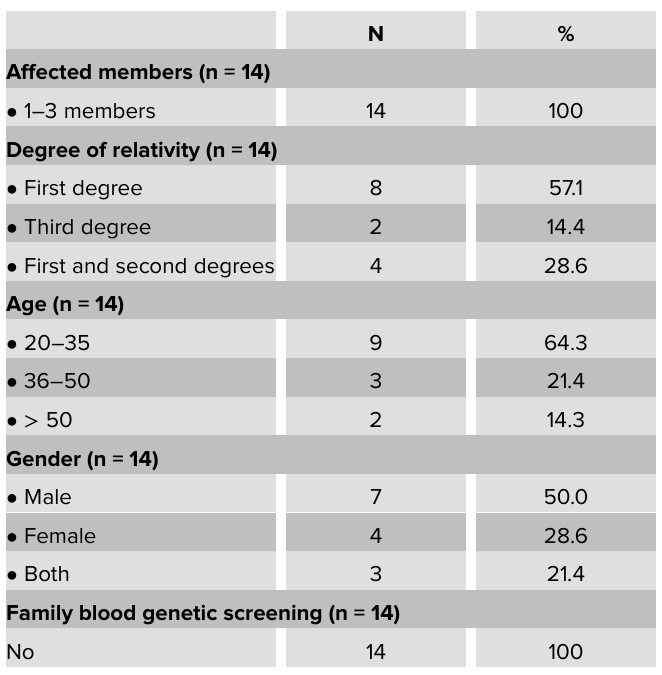
Table 4: Characteristics of family members of PINK1 early onset